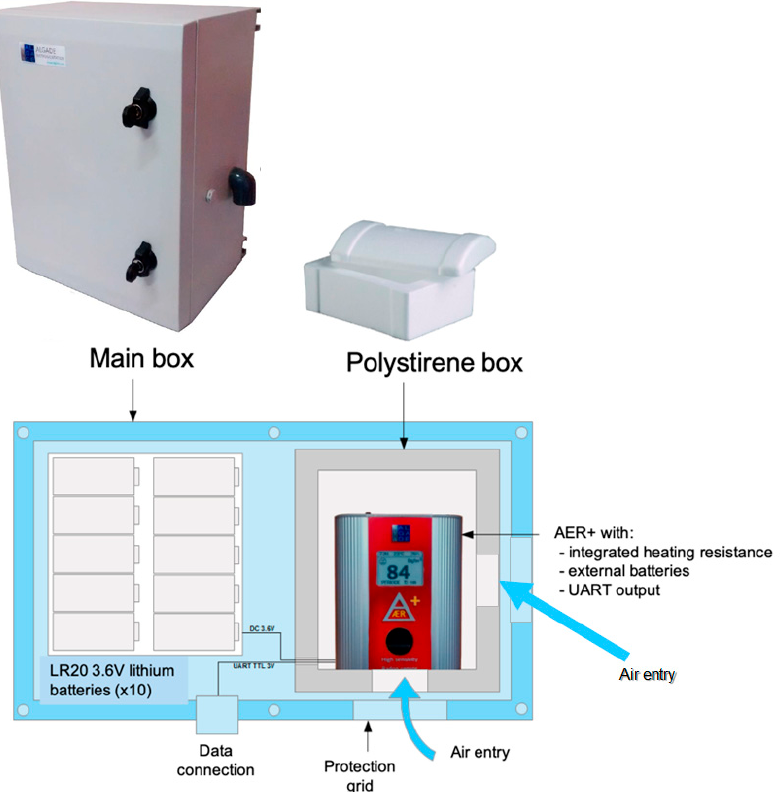
Figure 1. Tropicalization of ÆR+ radon probe by Algade. The dimensions of the main box are 400 × 300 × 210 mm.